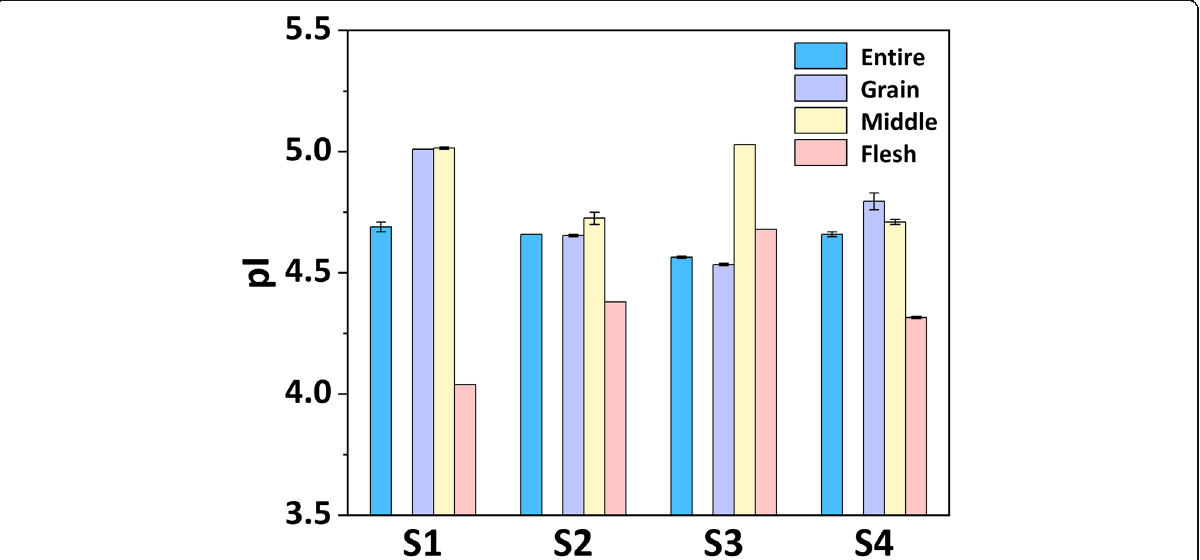
Fig. 5 pIs of the entire wet white and each layer of wet white retanned with multiple retanning agents (S1: 3% AR for 30 min, then adding 3% ME and 3% MR for 60 min; S2: 3% ME and 3% MR for 30 min, then adding 3% AR for 60 min; S3: 3% AAR for 30 min, then adding 3% ME and 3% MR for 60 min; S4: 3% ME and 3% MR for 30 min, then adding 3% AAR for 60 min)